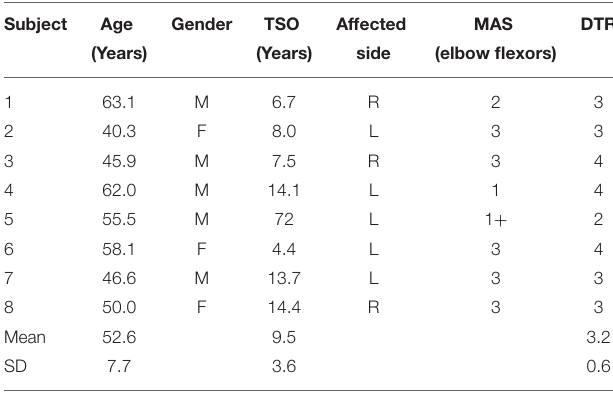
TABLE 1 | Baseline characteristics of participants.